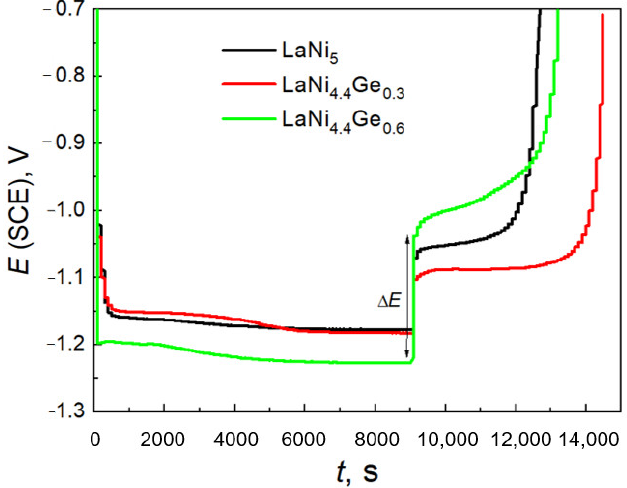
Figure 5. Galvanostatic charge/discharge curves for the 20th cycle. For the LaNi 4,6 Ge 0.6 composite electrode the way Δ E determining is demonstrated.